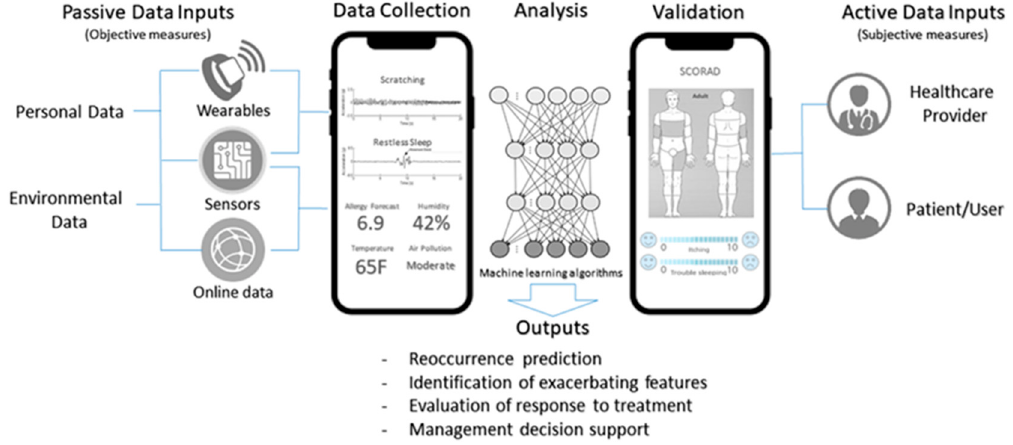
Figure 1. Example of integrated data collection and evaluation using a smartphone.